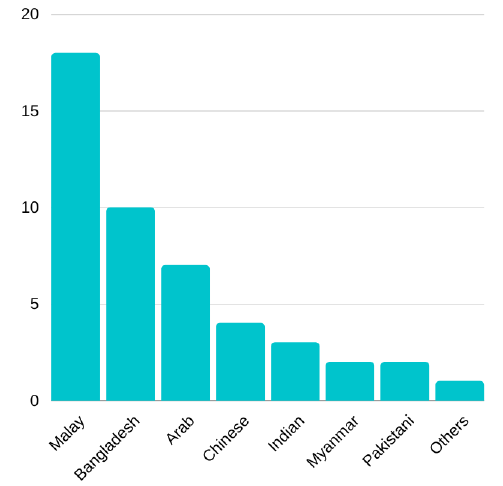
Figure 10. The demography of the participants’ race .